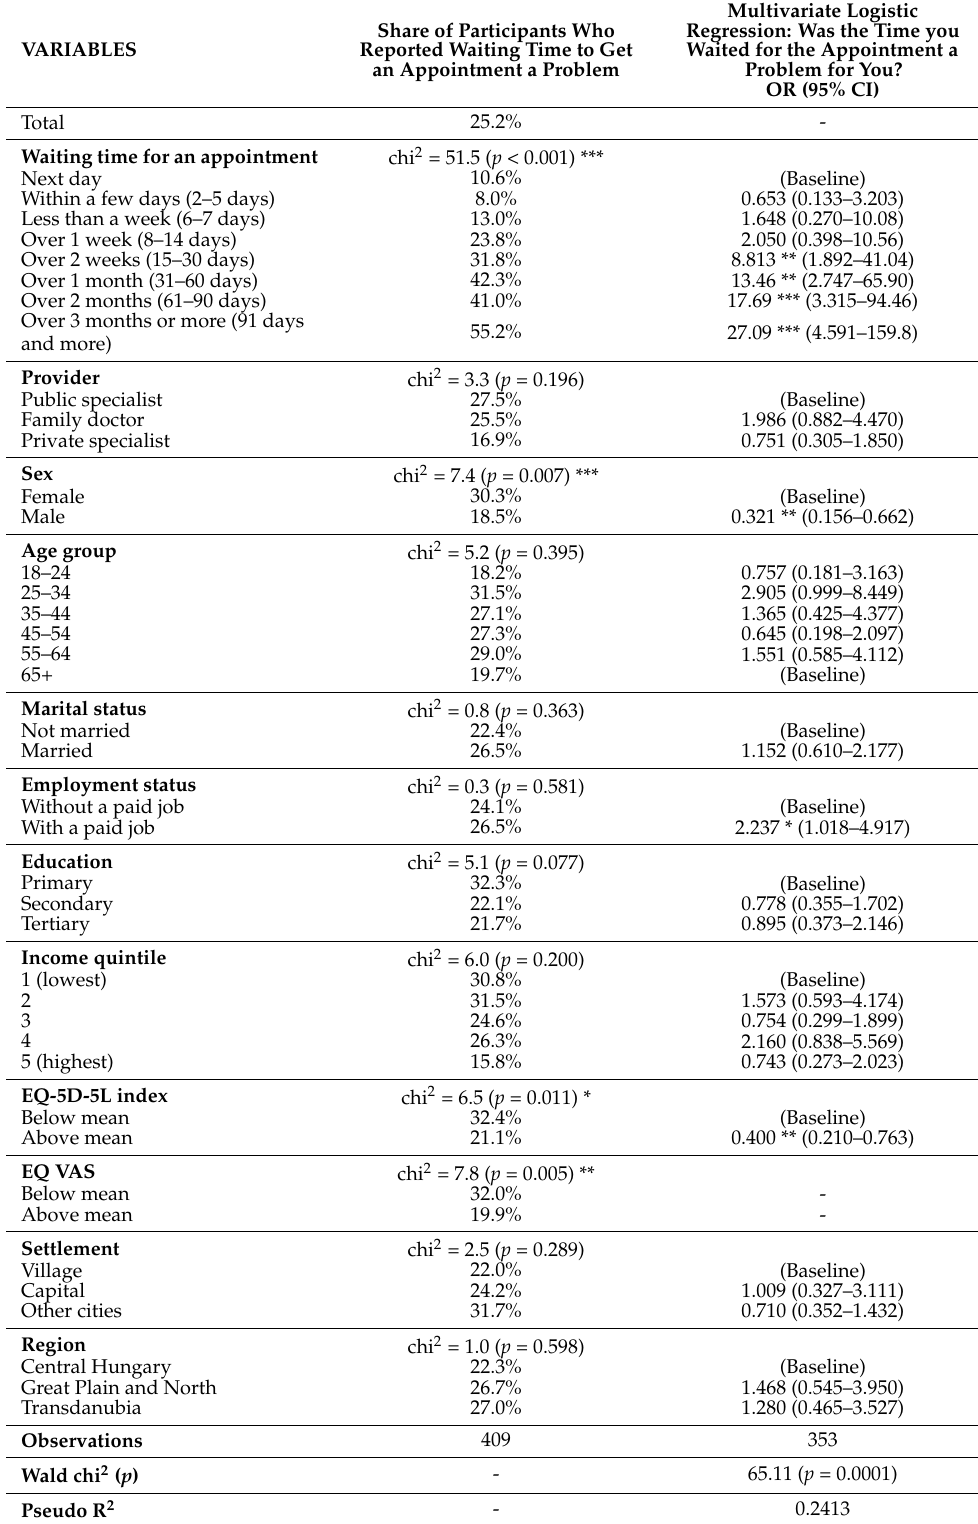
Table 6. Waiting time to get an appointment perceived as a problem: share of participants by covariates and multivariate logistic regression